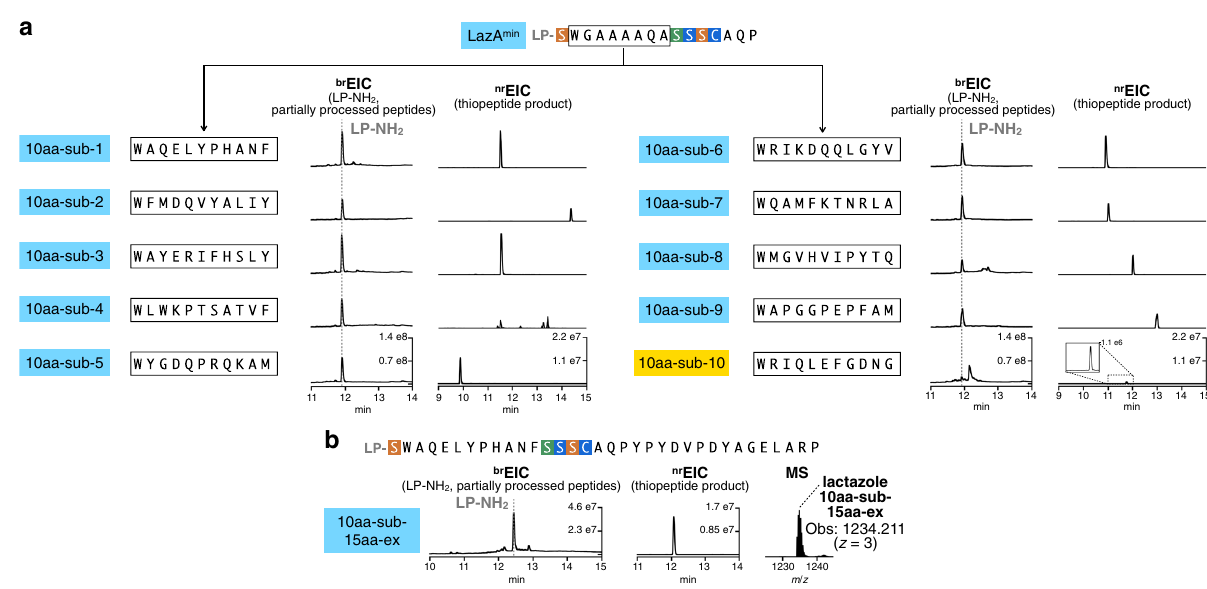
Fig. 4 Synthesis of lactazole-like thiopeptides with randomized sequences. a LazA min variants containing ten consecutively randomized amino acids were fi rst treated with LazDEF and then with LazBC, tRNA Glu , and GluRS (see Methods for details), and the outcomes were analyzed by LC-MS. Displayed are LC-MS chromatograms ( br EIC on the left showing partially processed linear peptides and LP-NH 2 after enzymatic treatment, and nr EIC chromatograms on the right for expected thiopeptides generated at m / z 0.10 tolerance window). Mutants highlighted in light blue indicate ef fi cient thiopeptide assembly; in yellow, inef fi cient thiopeptide formation accompanied by the accumulation of linear intermediates and side products. One construct, 10aa-sub4, resulted in eight different thiopeptides, partial annotation of which can be found in Supplementary Fig. 20. Ef fi cient in-vitro biosynthesis observed in nine out of ten cases underscores the substrate plasticity of FIT-Laz. b LC-MS chromatograms as in a for the enzymatic processing of a 34 amino acid-long LazA min variant on the left with a zoomed-in mass spectrum of the produced thiopeptide on the